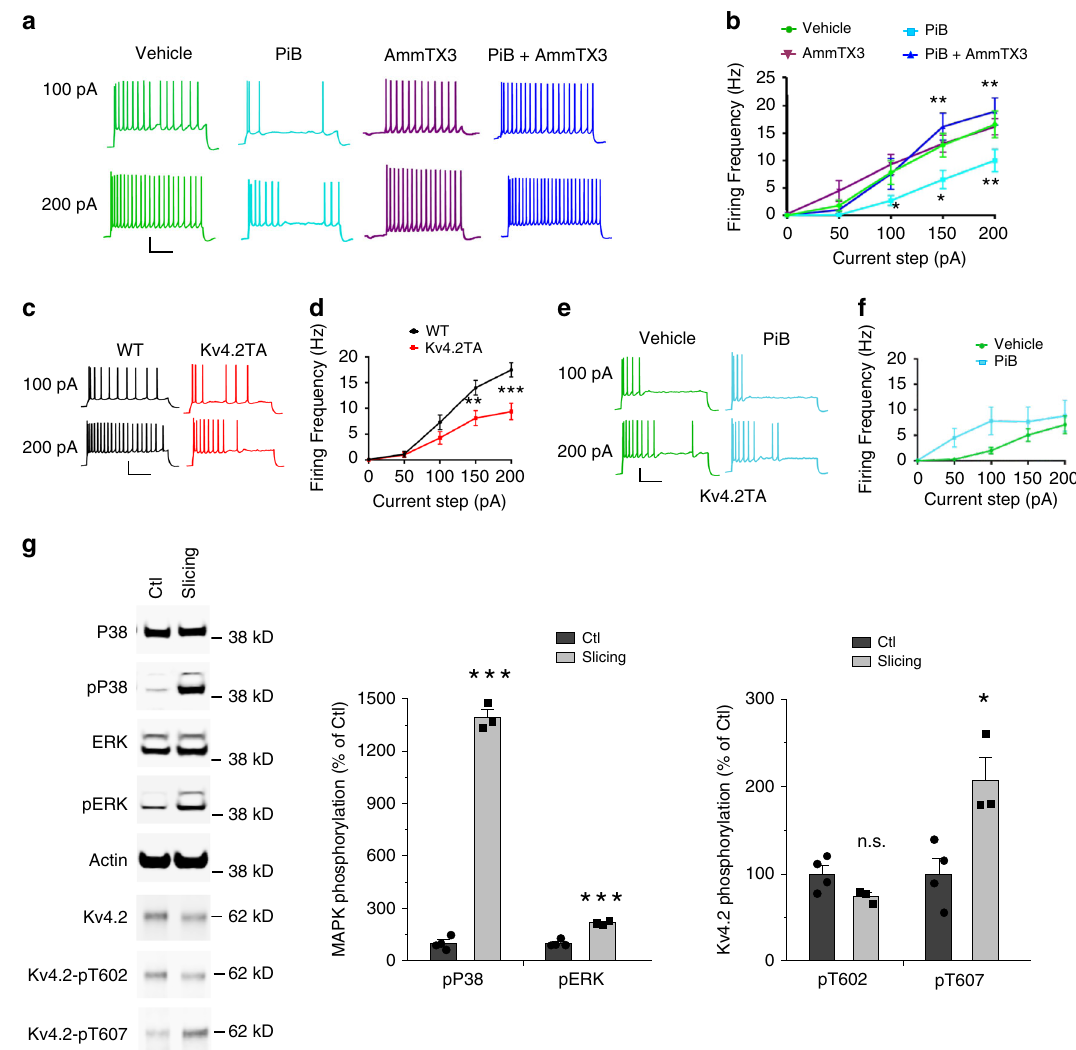
Fig. 5 P38-Pin1-Kv4.2 pathway regulates neuronal excitability. a , b Pin1 inhibitor PiB (4 µ M) reduces pyramidal cell excitability in WT mouse hippocampal brain slices. a Current steps at 100 pA and 200 pA result in reduced fi ring frequency with PiB application (teal) ( n = 13) relative to vehicle (green) ( n = 14). This reduction is rescued by co-application of AmmTX3 (250 nM) (blue) ( n = 7). Scale: 30 mV / 250 ms. b , PiB signi fi cantly reduces AP fi ring frequency relative to vehicle in response to 100, 150, and 200 pA somatic current injections. This reduction is rescued by AmmTX3 application. Two- way ANOVA, * p < 0.05, ** p < 0.01. c , d Mutation of Kv4.2 T607 Pin1 binding site phenocopies pharmacological inhibition of Pin1 in WT. c Pyramidal cells from Kv4.2TA slices display reduced fi ring frequency relative to WT over a range of increasing current injections. Scale: 30 mV/250 ms. d AP fi ring frequency is signi fi cantly reduced after 150 and 200 pA somatic current injections in Kv4.2TA ( n = 22) relative to WT ( n = 20), two-way ANOVA, ** p < 0.01, ***p < 0.001. e , f Pin1 inhibition with PiB has no effect in Kv4.2TA mice. e Pyramidal cells from Kv4.2TA slices display similar AP fi ring patterns when treated with vehicle ( n = 14) and PiB ( n = 14). Scale: 30 mV/250ms. f No signi fi cant changes are observed in Kv4.2TA pyramidal cell AP fi ring frequency with PiB exposure, Two-Way ANOVA, p > 0.05. g Brain slicing and recovery activates p38 and increases pT607 of Kv4.2. Adult mouse brains were either sliced as for electrophysiological recordings or dissected as for biochemical assays. Same brain regions were used. n = 4 for ctl and 3 for slicing. T -test. * p < 0.05, *** p < 0.001. Data are presented as mean ± performed voltage-clamp recordings from outside-out patches revealed a signi fi cant increase in current density in patches pulled pulled from CA1 pyramidal somata. As in analysis of fi ring prop- from Kv4.2TA cells relative to WT (Fig. 6d, e). Additionally, while erties, we fi rst measured I A in WT slices exposed to Pin1 blocker, changes in macro current inactivation, rise time and voltage- dependence of activation and inactivation were indistinguishable PiB (4 µM). We found that PiB exposure signi fi cantly increased I A density relative to vehicle (.1% DMSO) (Fig. 6a, b). Additionally, as between the lines (Fig. 6c, Supplementary Tab. 1), a leftward shift in we identi fi ed p38 and MEK-mediated phosphorylation at the Pin1 the normalized recovery from inactivation curve was identi fi ed in binding site on Kv4.2, we tested their effect in facilitating Pin1 Kv4.2TA cells (Fig. 6h, i). Single exponentials fi tted to the nor- regulation of I A . We identi fi ed that pharmacological blockade of malized recovery curves yielded a statistically signi fi cant reduction p38 (SB230580) also signi fi cantly increased I A density relative to in the time constant of I A recovery in Kv4.2TA cells, suggesting vehicle while MEK inhibition (PD98059) displayed no signi fi cant these channels recover more quickly from inactivation relative to effect (Fig. 6a, b). Further, consistent with the observed effects on WT (Fig. 6i). Importantly, pharmacological blockade of Pin1 had fi ring suggestive of enhanced I no effect on I A in Kv4.2TA mice (Supplementary Fig. 7). Taken A in Kv4.2TA mice, isolation of I A